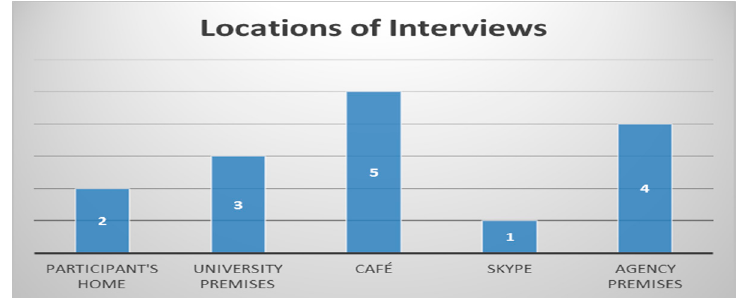
Figure 2. Location of interviews.